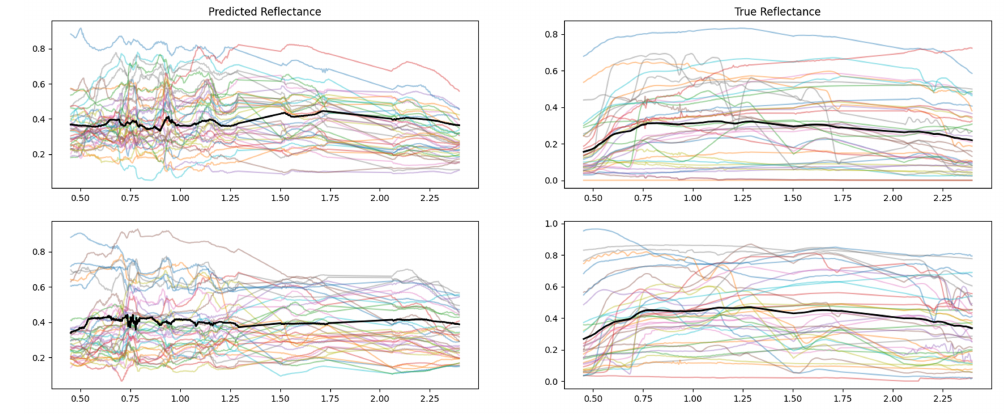
Figure 12. Two different sets of 40 endmembers in reflectance ( right ) and as predicted by the denoising autoencoder ( left